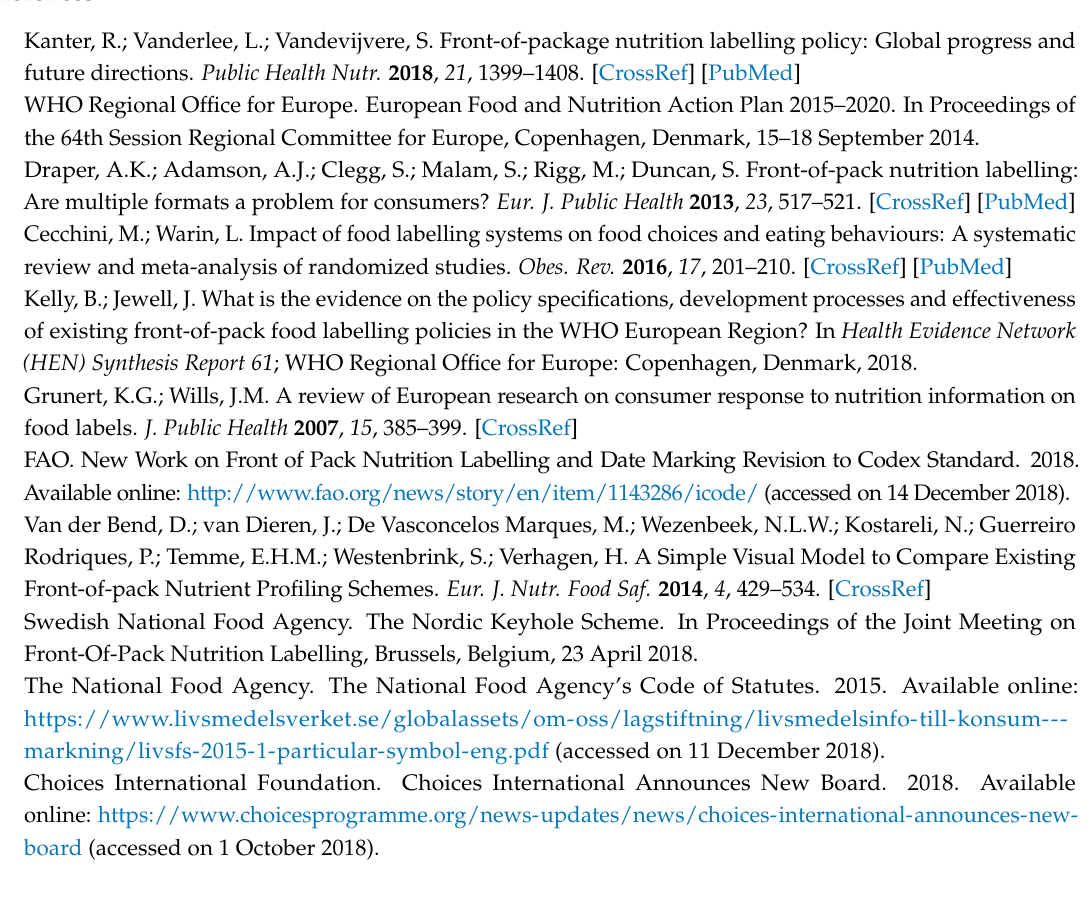
s1. Figure S1: Characteristics of Czech Choices label ‘Vim, co Jim’ shown in the Funnel Model, Figure S2: Characteristics of the Finnish Heart label shown in the Funnel Model, Figure S3: Characteristics of the Croatian Healthy Living (HL) label shown in the Funnel Model, Figure S4: Characteristics of the Slovenian Protective Food (PF) label shown in the Funnel Model, Figure S5: characteristics of the Evolved Nutrition Label (ENL) shown in the Funnel Model, Table S1: Qualifying and disqualifying components used in positive front-of-pack (FOP) labelling systems in Europe, Table S2: Qualifying and disqualifying components used in mixed and negative front-of-pack (FOP) labelling systems in